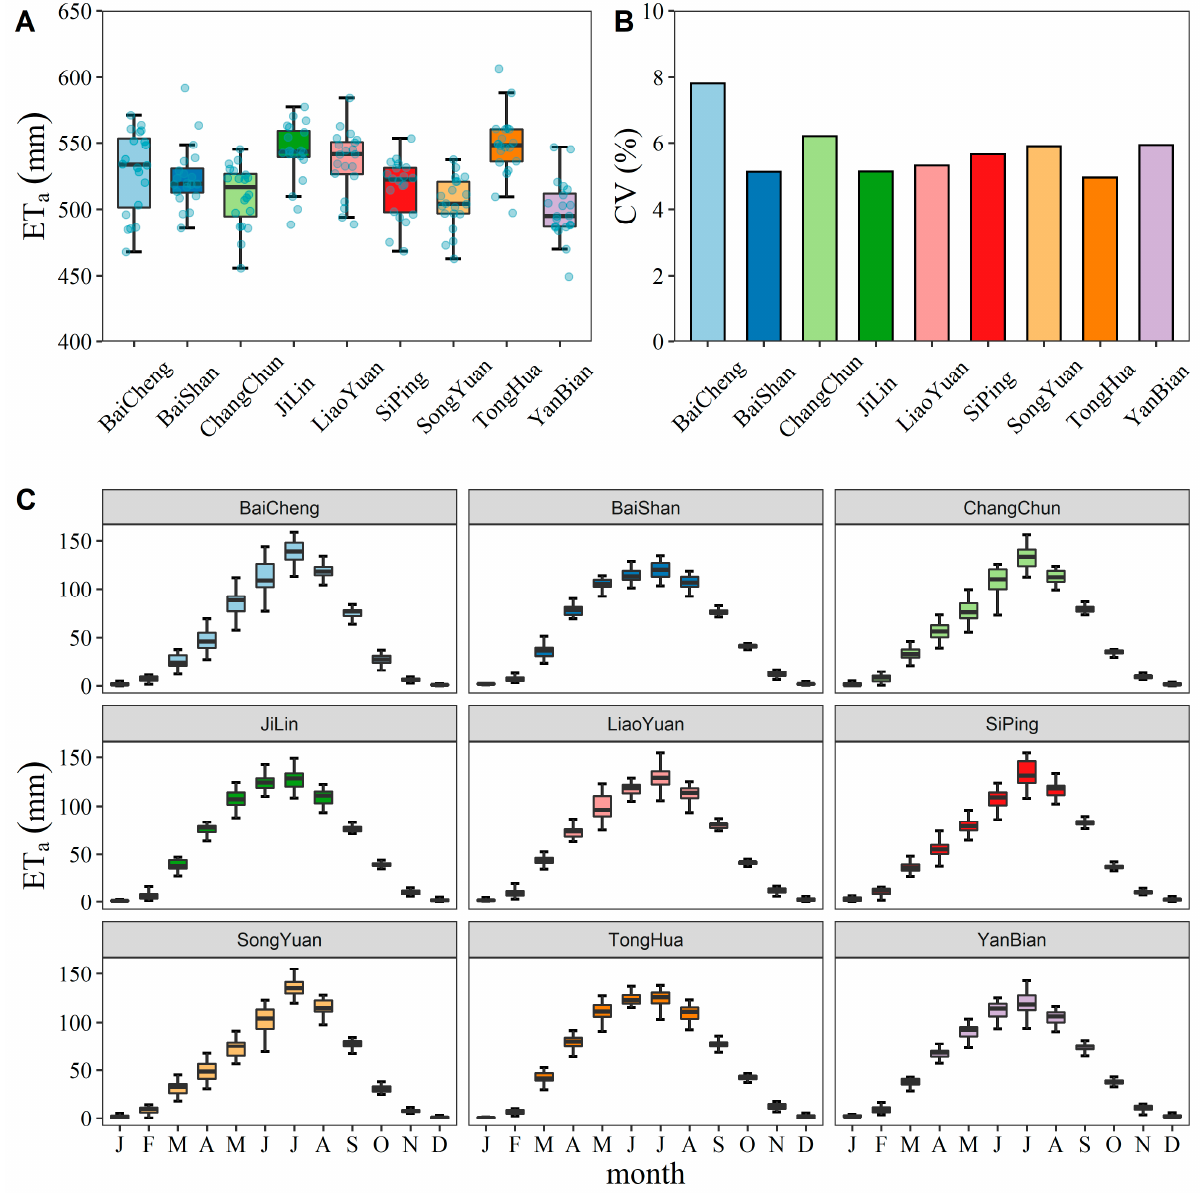
Figure 14. ET a of spring maize in each city of Jilin Province. ( A ) Multi-year average ET a in each city during the spring maize growing season from 2001 to 2020, ( B ) coefficient of variation (CV) of ET a during the spring maize growing season in each city from 2001 to 2020, and ( C ) monthly ET a in each city.